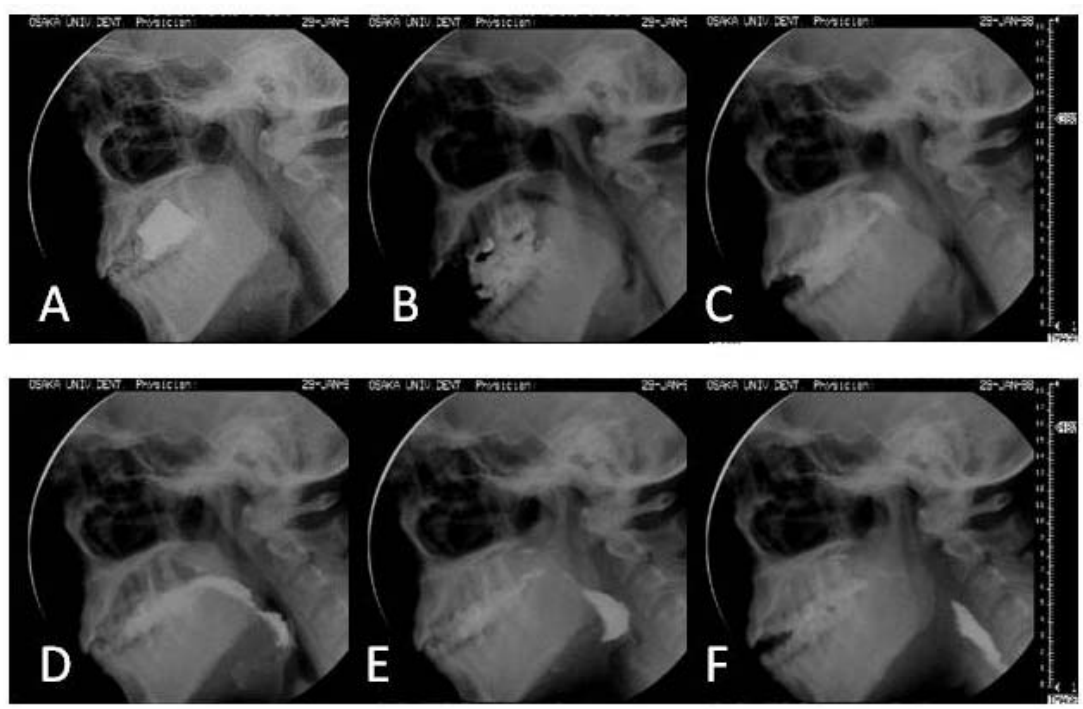
Figure 1. Process of mastication and swallowing of gummy jelly observed by VF